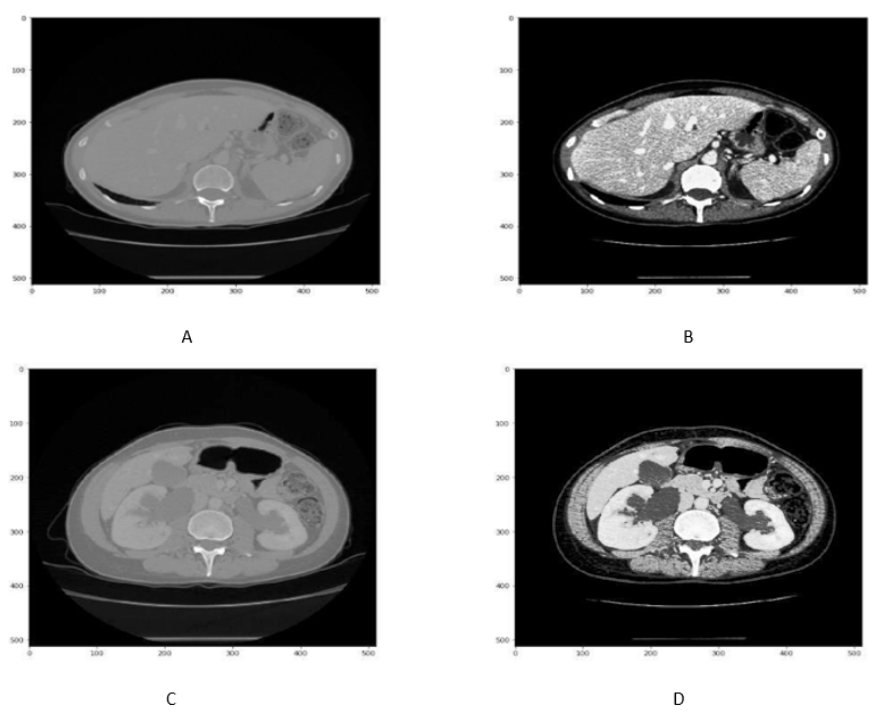
Figure 3. Figure shows that the CT slice ( A , B ) before histogram equalization , While CT slice ( C , D ) after histogram